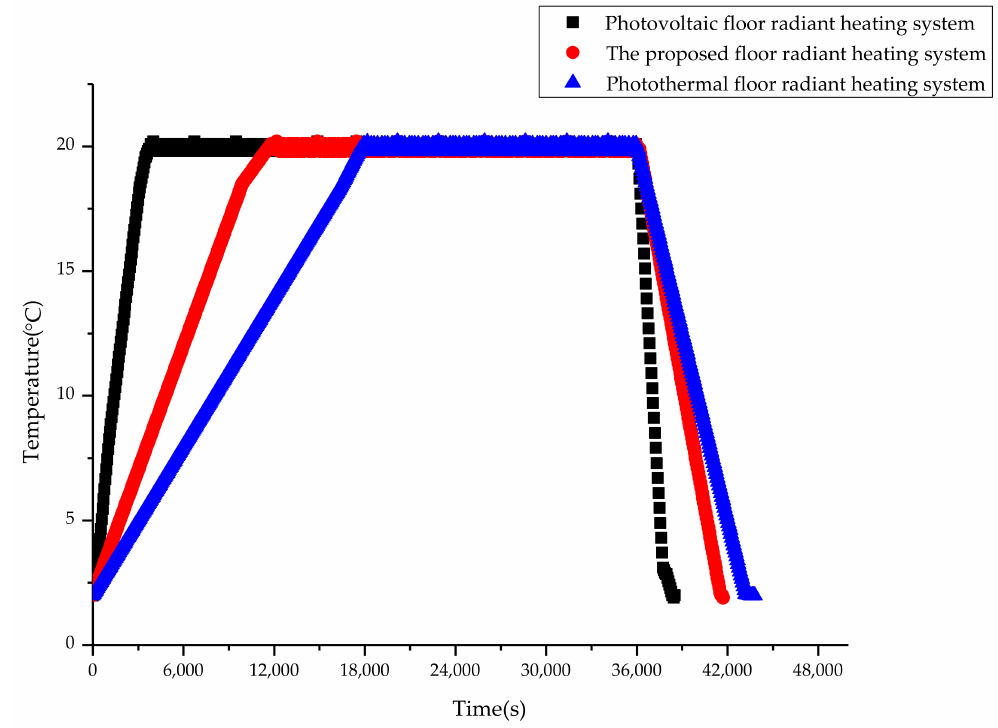
Figure 9. Indoor temperature changes of the three different heating